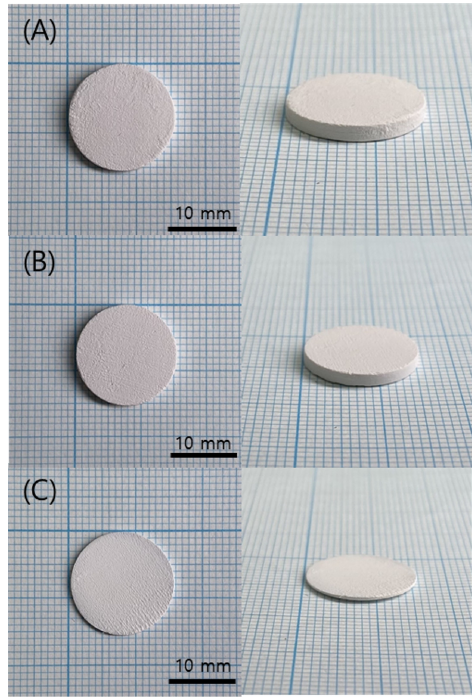
Polymers 2023 , 15 , x FOR PEER REVIEW Figure 12. Green body specimens according to various curing times: ( A ) 0.8 s; ( B ) 1 s; ( C ) 1.6 s.